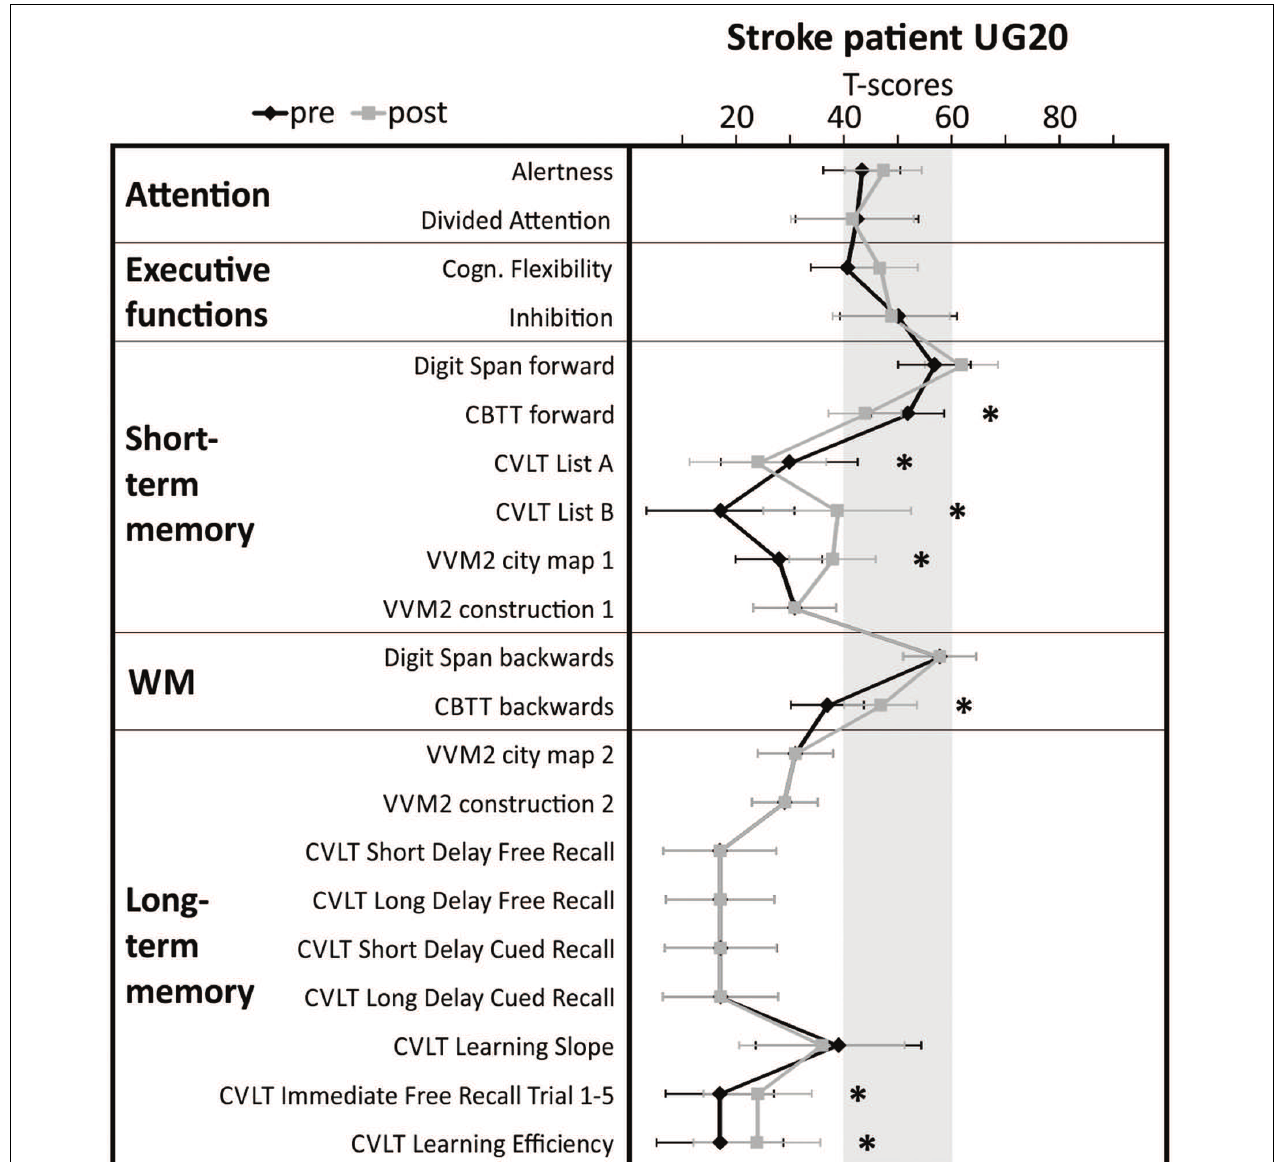
FIGURE 4 | Results of the detailed cognitive assessment carried out in stroke patient UG20 before and after neurofeedback training. Shaded area indicates norm scores. Test performance is expressed in T-scores with population mean M = 50 and standard deviation SD = 10. Neuropsychological test scores and confidence intervals for measurements of alertness, divided attention, cognitive flexibility and inhibition scores were derived from tasks of the Testbatterie zur Aufmerksamkeitsprüfung (Zimmermann and Fimm, 2009). STM, short-term memory; LTM, long-term memory; CBTT, Corsi Block Tapping Test (Schellig, 2011); VVM2, Visueller und Verbaler Merkfähigkeitstest 2 (Schelling and Schächtele, 2001); CVLT, California Verbal Learning test (Niemann et al., 2008). Significant differences between pre- and post-test (critical difference analysis on the group level, Huber, 1973) are marked with asterisks ( ∗